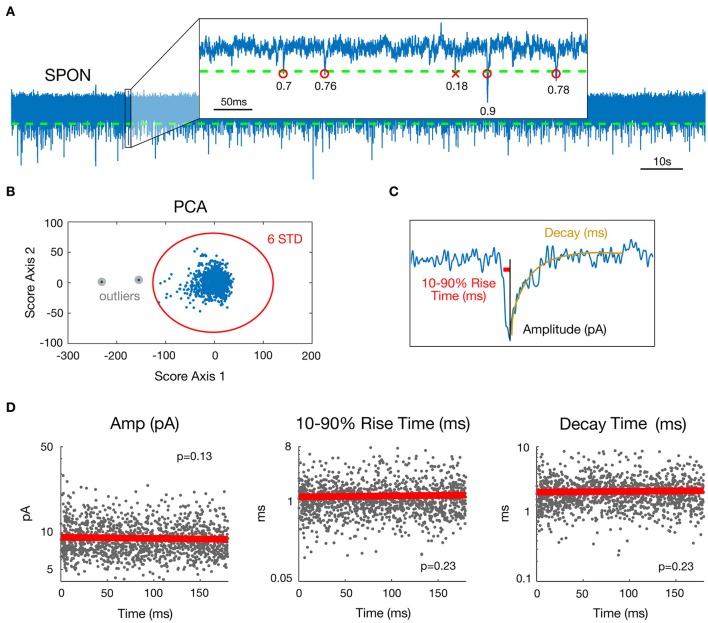
Estimation of mEPSC parameters in a representative SPON cell exhibiting spontaneous inward currents. (A) 180 s whole-cell recording time signal (top) and expanded 0.5 s time interval. Detection threshold for mEPSCs is represented by a dashed line and R2 goodness-of-fit coefficients for the linear exponential mEPSC model are indicated for each detected event. (B) As a step of outlier detection, a principal component analysis was applied to the matrix of mEPSC time signals. Events that appeared beyond the mean ± 6 SD of at least one of the two first components were removed then process was iterated (one time was enough in the example shown here). (C) Estimated parameters illustrated for one detected mEPSC. The Decay parameter corresponds to the time constant of the exponential decay shown in yellow. (D) Stability over time assessment for the three mEPSC parameters estimated from the model. The plain bold line is the linear regression and all p-values for the F-test were >0.0037, defined as the significance threshold after Bonferroni correction (see methods).